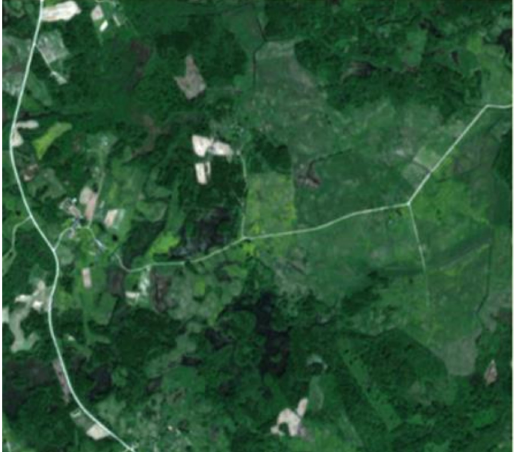
Figure 1. Sentinel-2A image taken on 10 April 2018 (B4-B3-B2 colour composite).